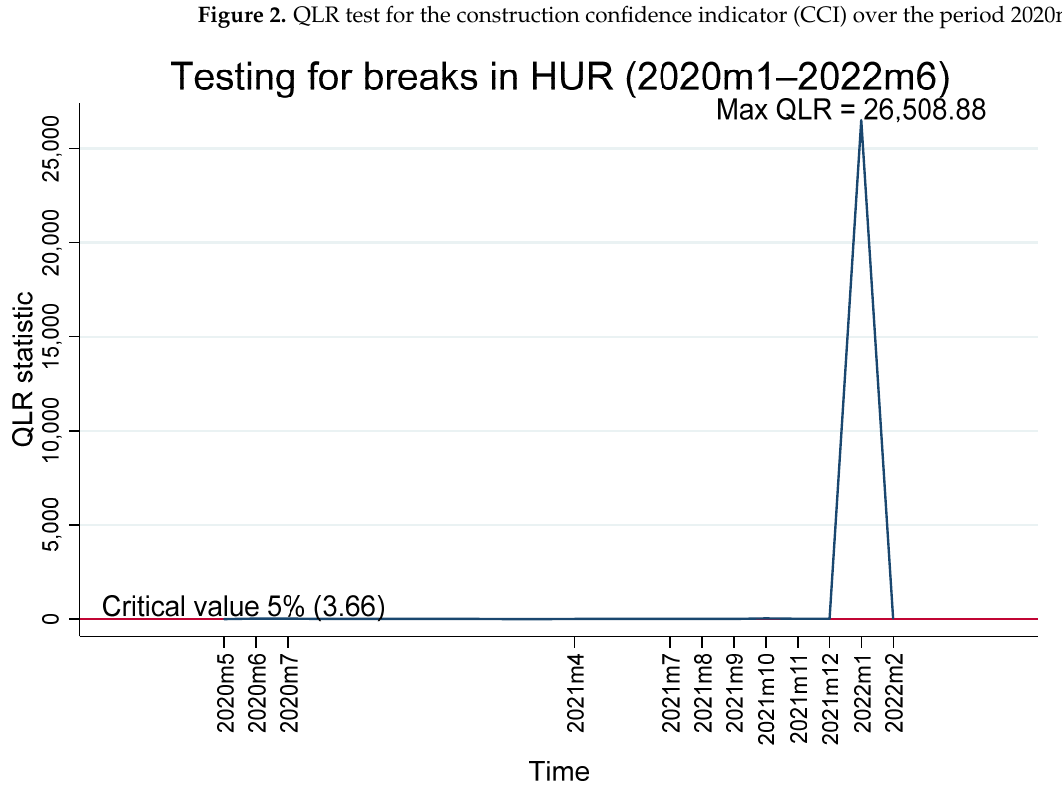
Figure 3. QLR test for the harmonized unemployment rates (HUR) over the period 2020m1–2022m6.